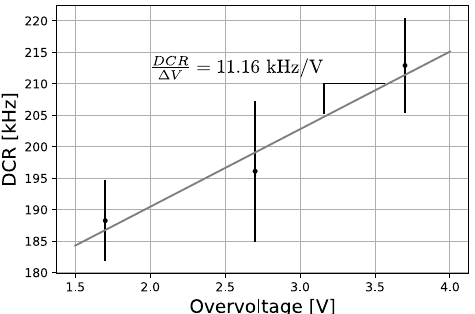
Figure 9. Dark count rate as a function of the over-voltage ranging from (1.7V to 3.7V) at 25 ◦